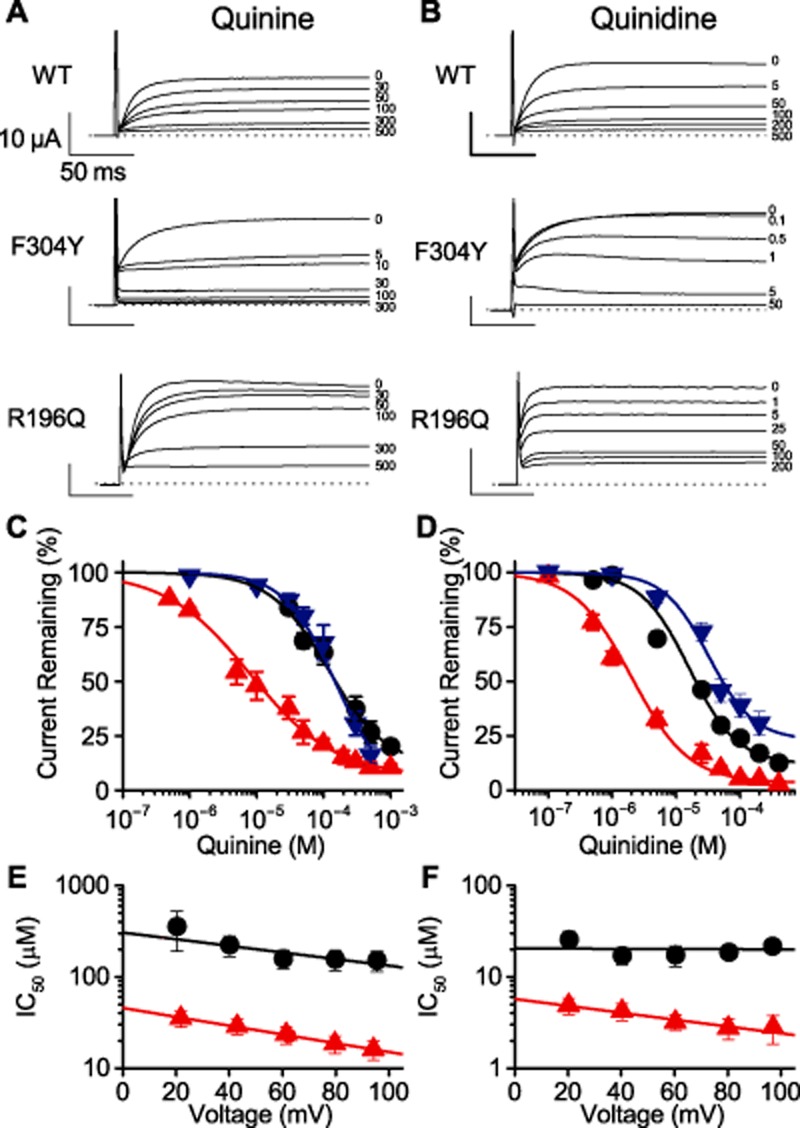
Concentration-dependent inhibition of WT, F304Y and R196Q mSlo3 currents by quinine and quinidine. Representative traces recorded before (0) and in the presence of quinine (A) and quinidine (B) (concentrations in μM as indicated). The dashed line represents the zero-current levels and scale bars represent equivalent current amplitudes and timescales. Mean (± SEM) concentration–inhibition plots for quinine (C) and quinidine (D) inhibition of WT mSlo3, R196Q mSlo3 and F304Y mSlo3 at +100 mV, fitted by the Hill equation provided in the Methods. Apparent voltage-dependence of the IC50 for quinine (E) and quinidine (F) of WT and F304Y mSlo3 currents. The data are described and analysed further in the main text. For key to symbols used see Figure 1.